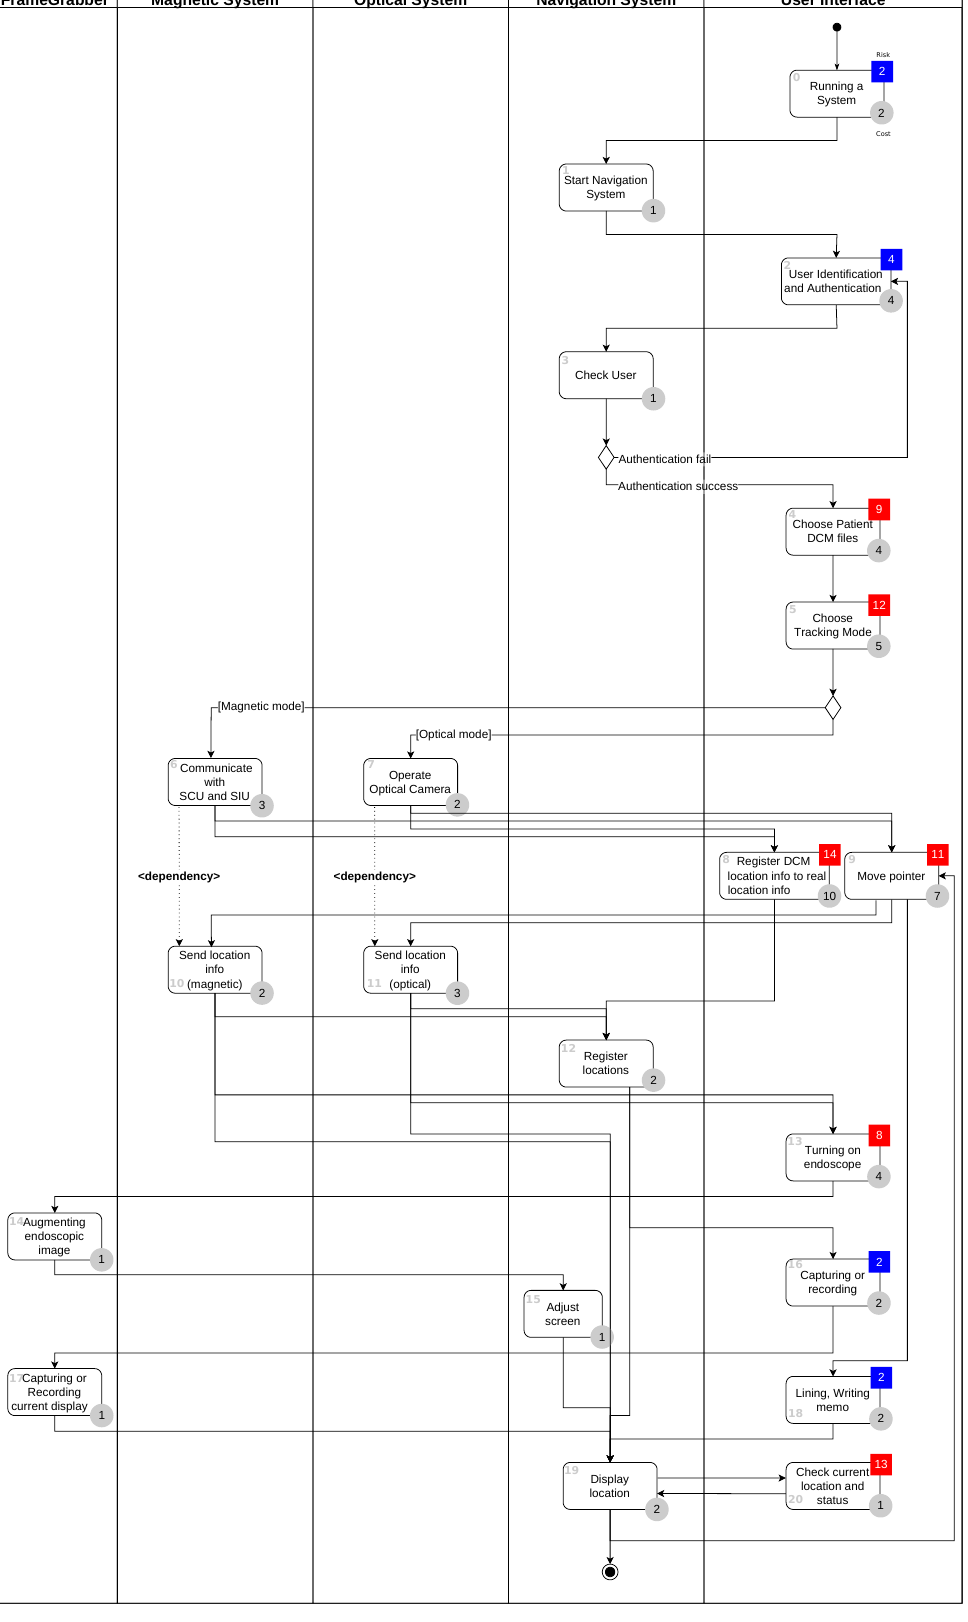
Figure 11. The uFMEA-based activity diagram for sinus surgical navigation